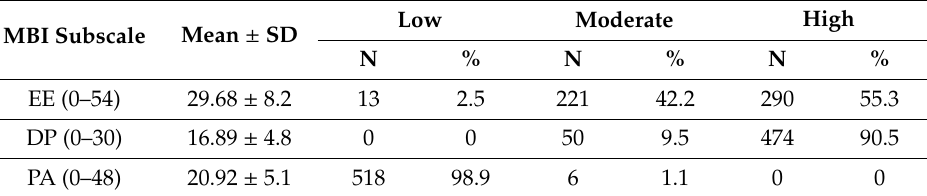
Table 3. Scores on the MBI